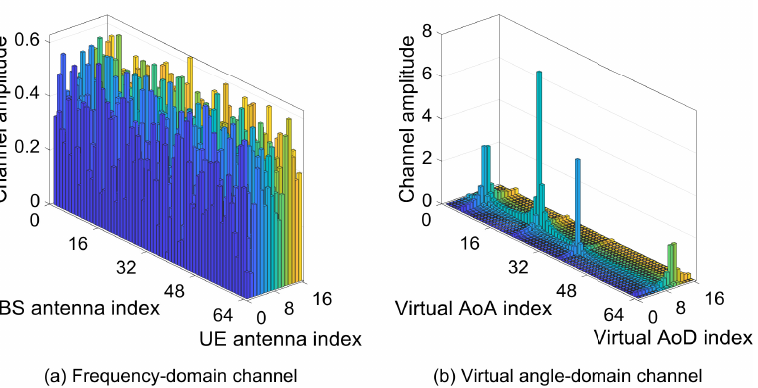
Figure 1. The illustration of the frequency-domain channel and the virtual angle-domain